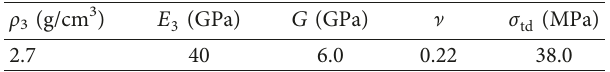
Table 3: Parameters of rock